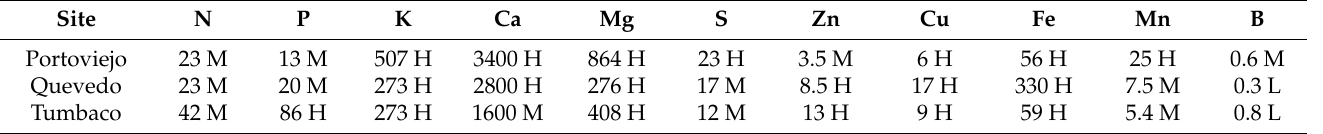
Table 4. Soil nutrient content (mg kg − 1 ) of the passion fruit orchards in the INIAP ´ s research